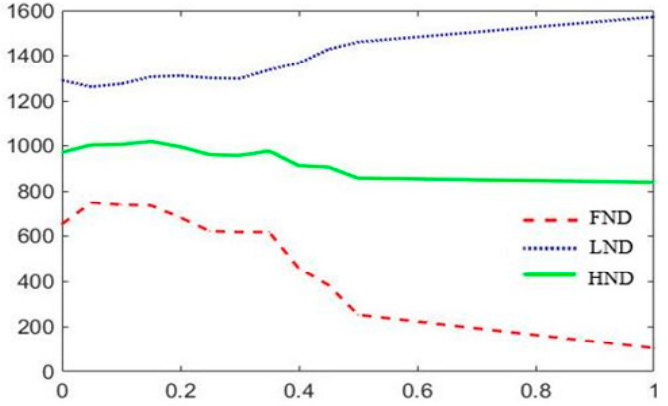
Figure 10. Network lifetime schematic diagram of the trend of w 2.